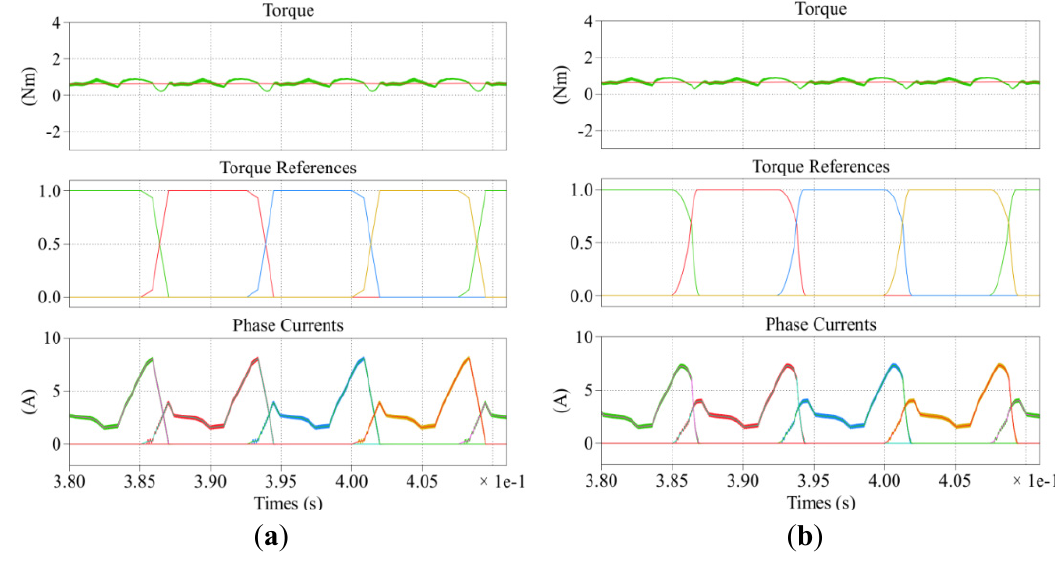
Figure 10. Simulation results at 300 rpm: ( a ) asymmetric TSF; ( b ) non-unity TSF.